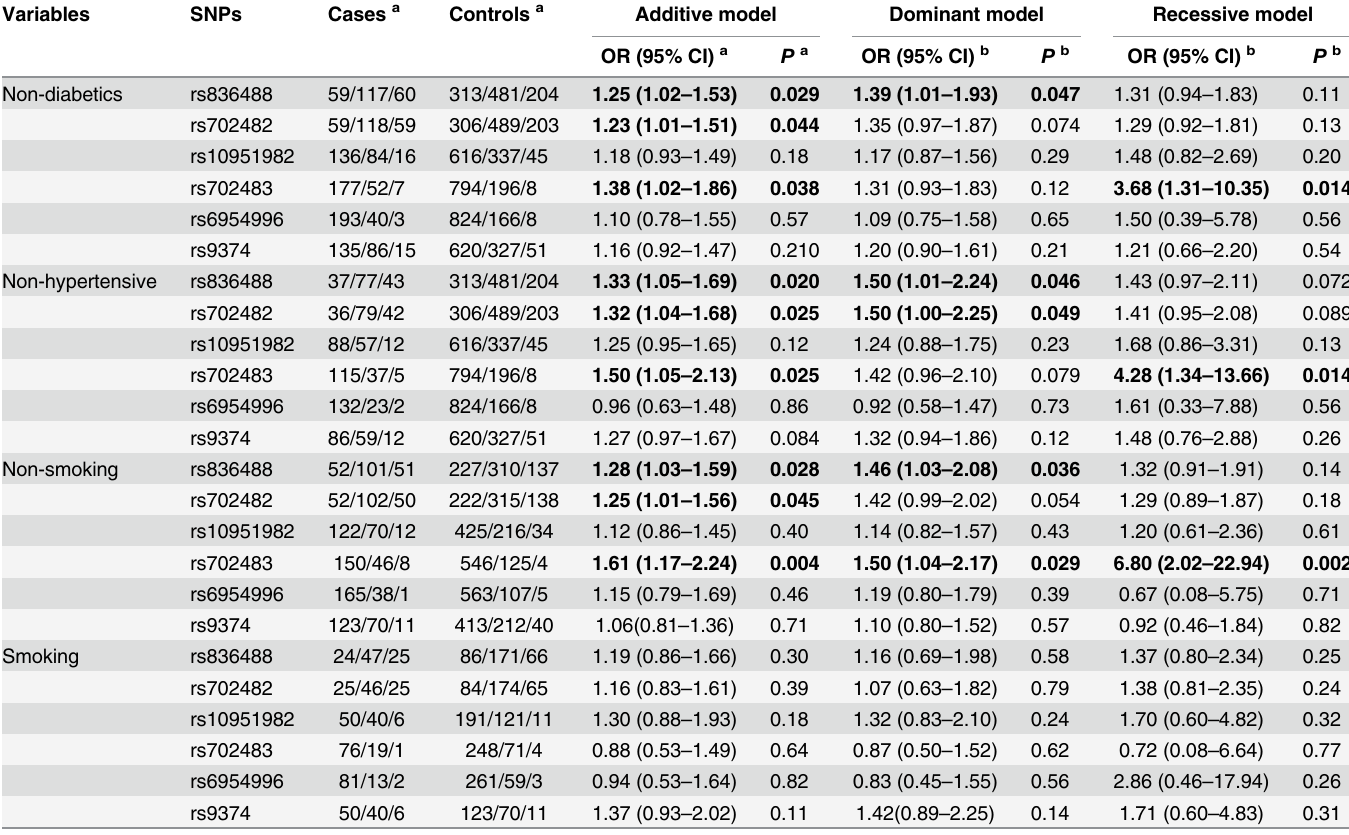
Table 5. Stratification analysis of RAC1 polymorphisms in renal transplant recipients and healthy